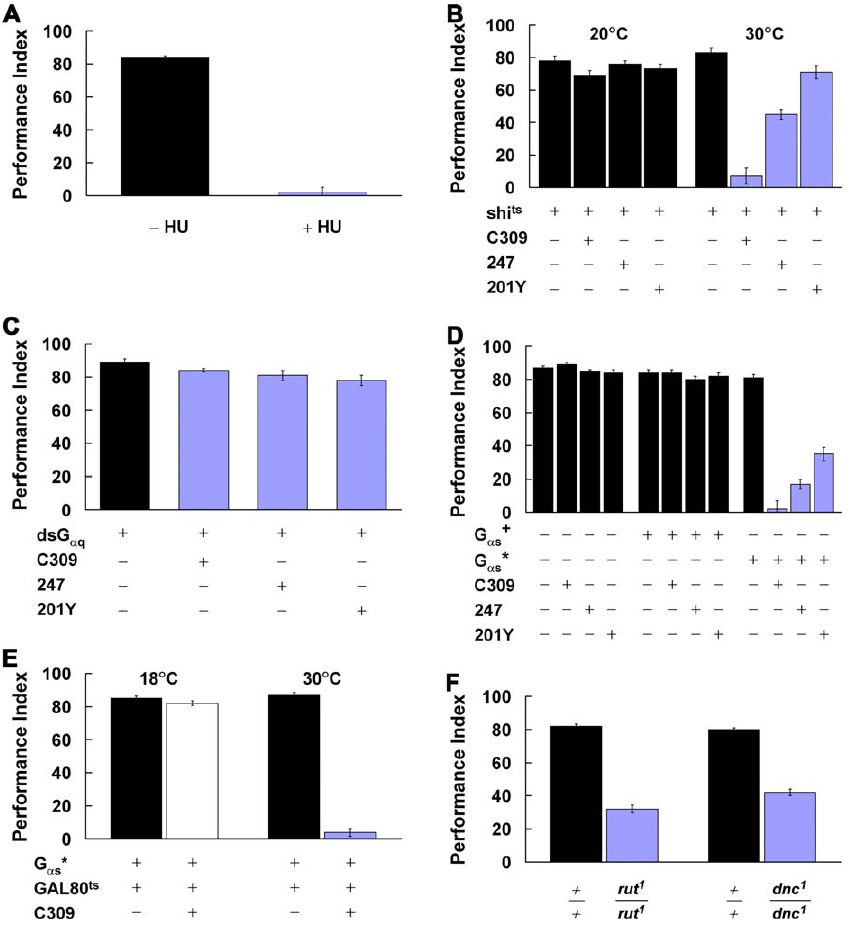
Figure 4. Conditioned Odor Identity Discrimination Requires Synaptic Transmission from MB and Depends on G a s Signaling Conditioned odor identity discrimination between MCH and BA was (A) abolished by MB ablation ( þ HU), (B) disrupted by transient block (30 8 C) of synaptic transmission from MB in C309/shi ts , 247/shi ts , or 201Y/shi ts flies, (C) mildly affected by disruption of G a q in MB of ds G a q /C309, ds G a q /247, or ds G a q /201Y flies, (D) severely diminished by developmental disruption of G a s in MB of G a s */C309, G a s */247, or G a s */201Y flies, (E) abolished by adult- specific, physiological disruption of G a s in MB of G a s *, GAL80 ts /C309 flies at restrictive (30 8 C) but not permissive (18 8 C) temperature, and (F) disrupted in rut or dnc mutants. n ¼ 6 PIs for each group.